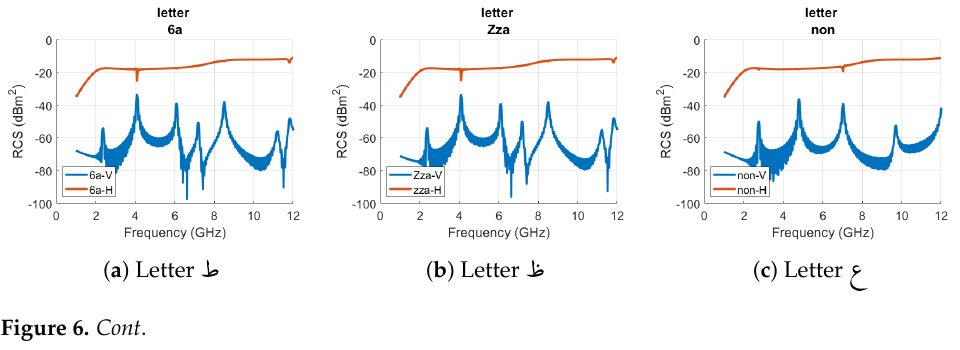
Figure 5. RCS results of Arabic letter tags ( font type and font size of 28.